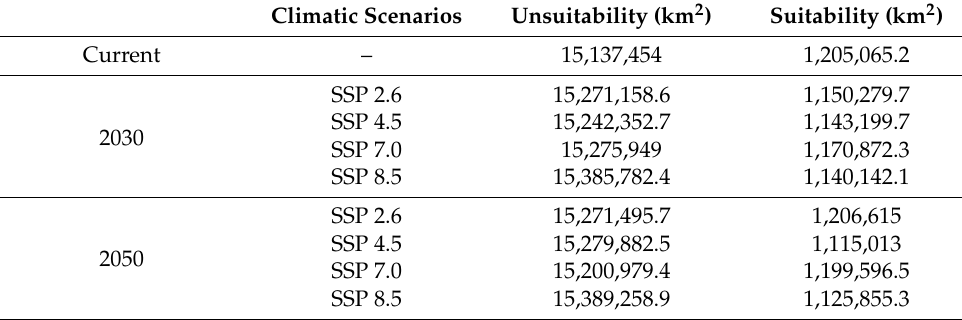
Table 10. Predicted suitable areas under the current and future climatic conditions during January– May